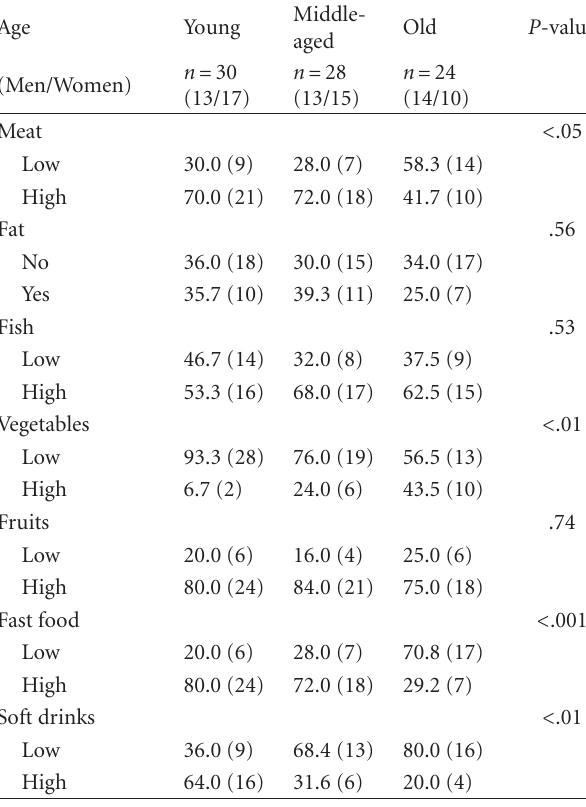
Table 2: Eating frequency by age groups.